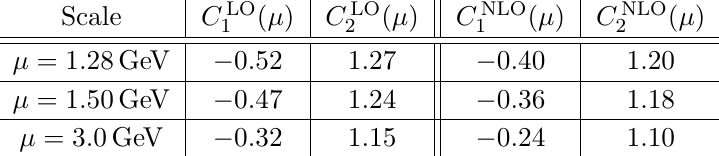
Table 21. Numerical values of the Wilson coefficients C 1 , 2 at the leading order (LO) and next-to- leading-order (NLO) evaluated with the five-loop running of α